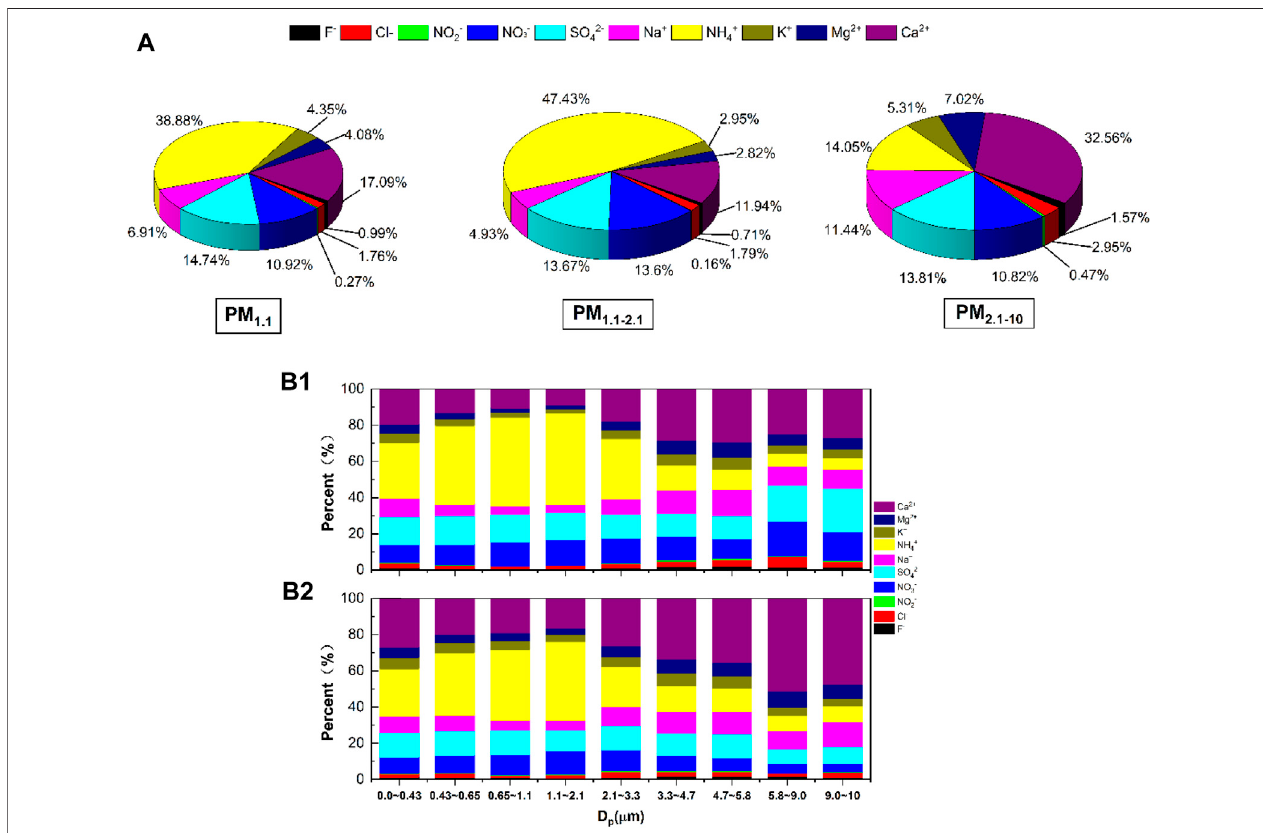
FIGURE3| Masspercentage of (A) majorionsinthePM 1.1 ,PM 1.1-2.1 and PM 2.1-10 ,andrationsdistribution ofWSIImassconcentrationindifferentsizedistribution and period (b1: before the Meiyu period, b2: during the Meiyu